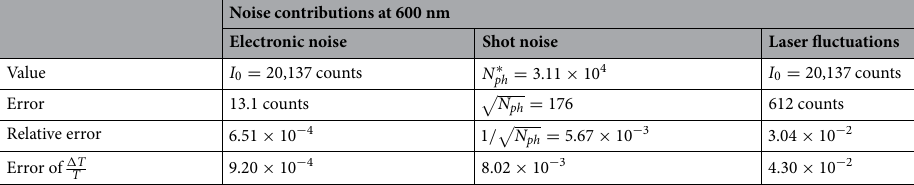
Table 1. Individual noise contributions of the obtained standard deviation spectrum for the pixel corresponding to 600 nm. ∗ For this wavelength, the conversion efficiency of the CMOS is 79 %